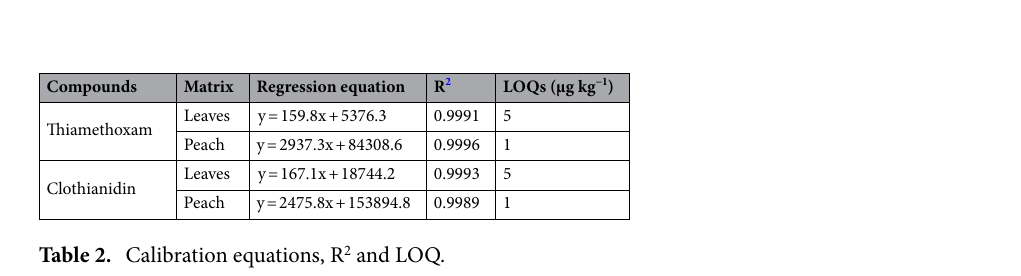
Table 1. Control effect of thiamethoxam at low and high concentrations on Myzus persicae under two application methods. Values are means ± SE of the three replicates. Note: The means within each rank followed by different letters are significantly different at p < 0.05 (Tukey’s test).